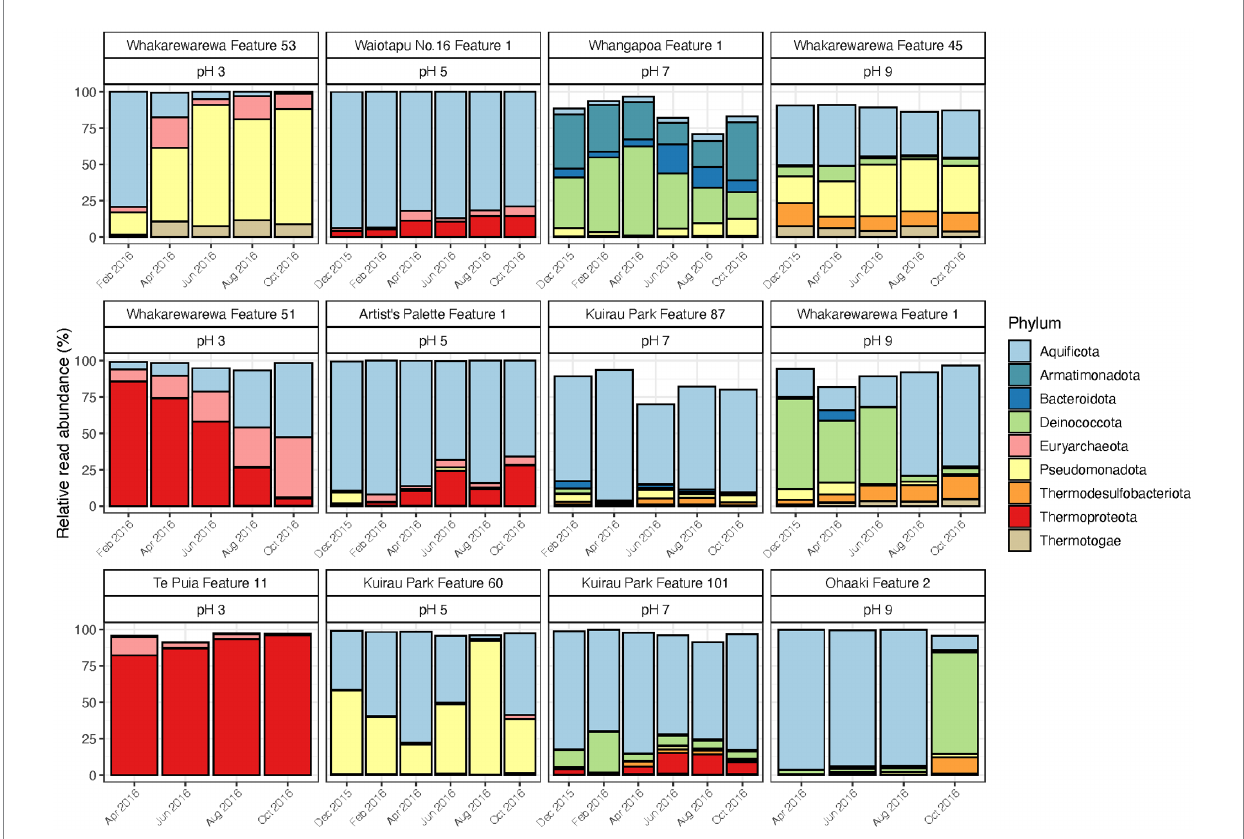
FIGURE 5 Temporal microbial community composition and relative abundance of geothermal features across the pH scale. Amplicon sequencing of the 16S rRNA gene was used to measure read abundance of taxa in spring communities, with only phyla >1% average relative abundance across all samples in this category shown. Geothermal features are grouped according to their respective pH group (pH 3, 5, 7, and